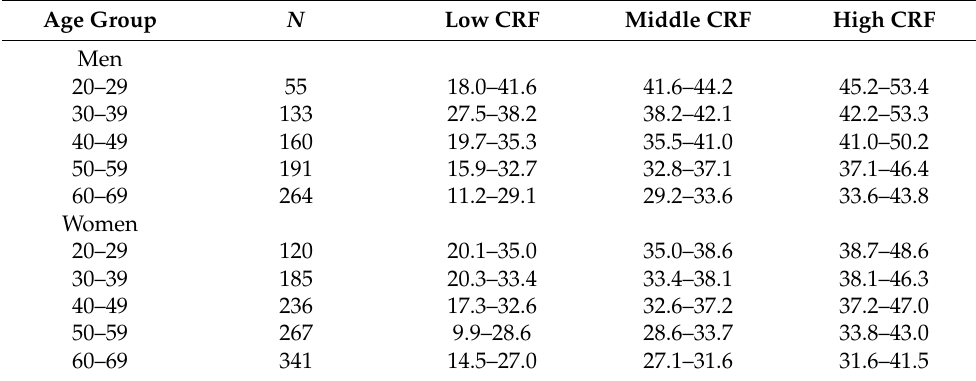
Table 1. Number of participants in each age group and maximal oxygen uptake (VO 2 max) range